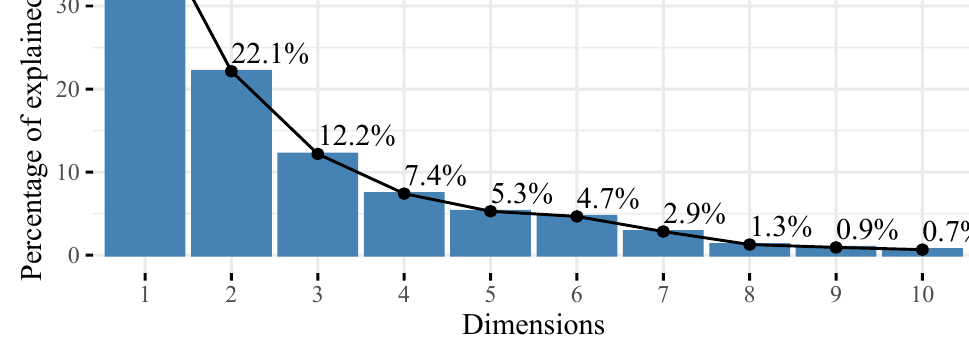
Figure 2. PCA plot.